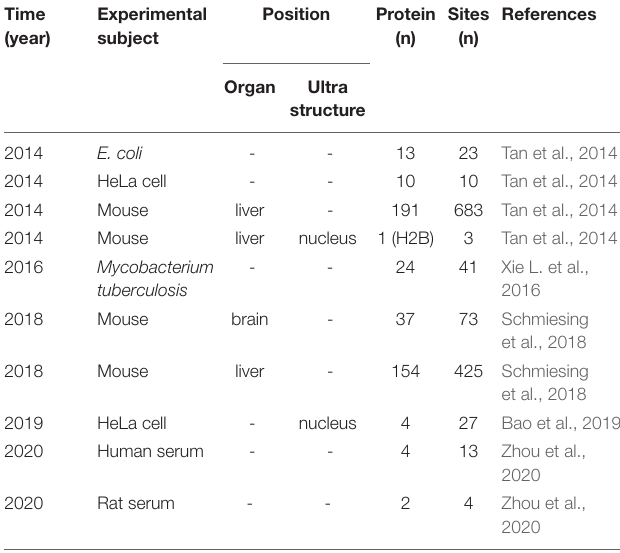
TABLE 1 | Information on glutarylated proteins and sites that have been